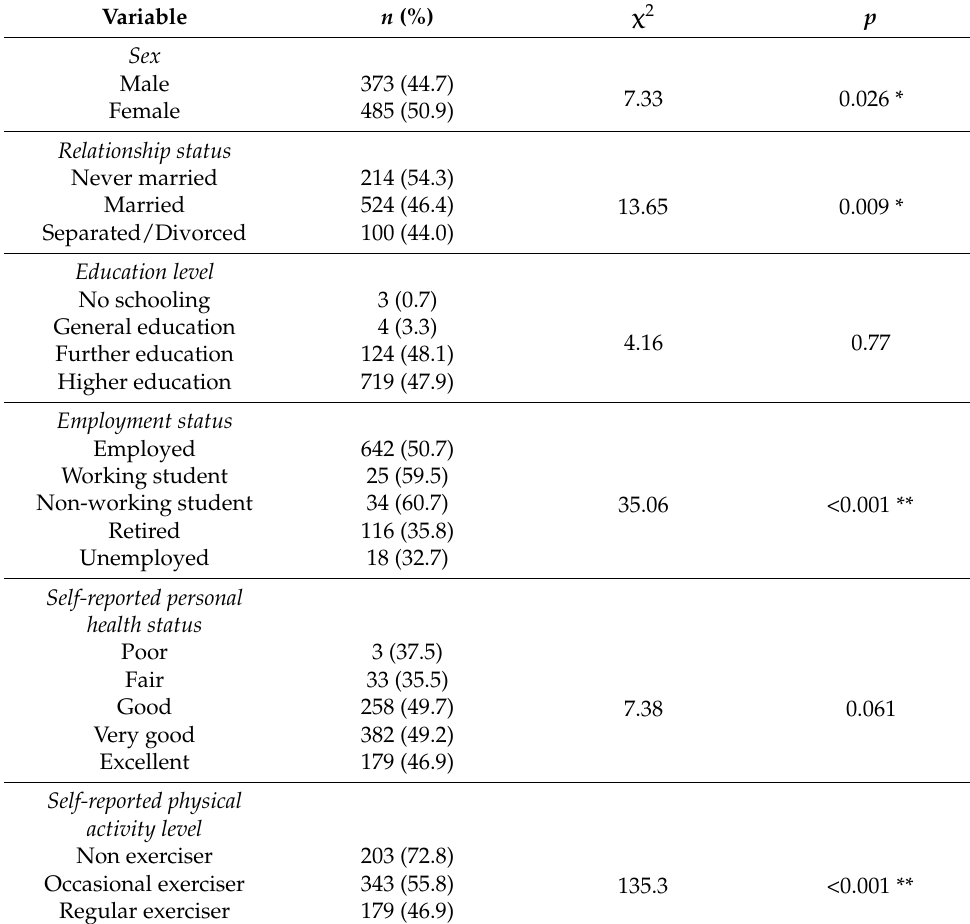
Table 3. Post- parkrun physical activity increases categorised according to demographic